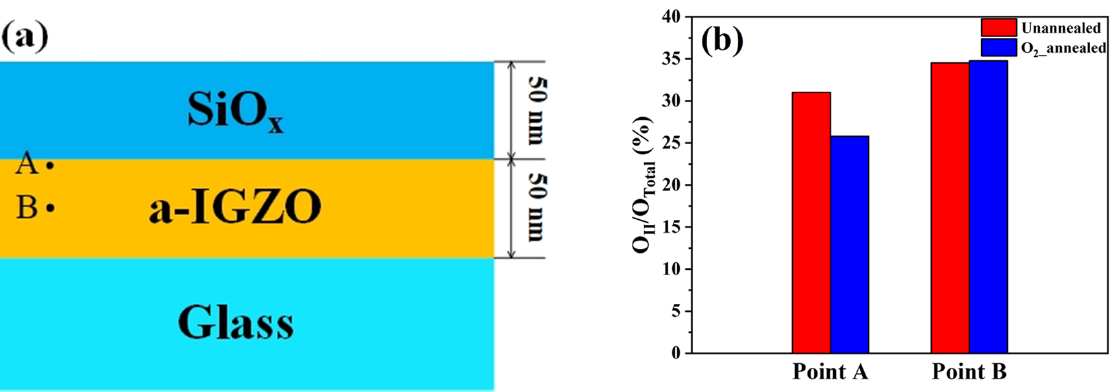
Figure 5. ( a ) The sample structure for the XPS depth profiling tests; ( b ) the area ratios of O II in the O1s peak of the unannealed and O 2 _annealed samples.